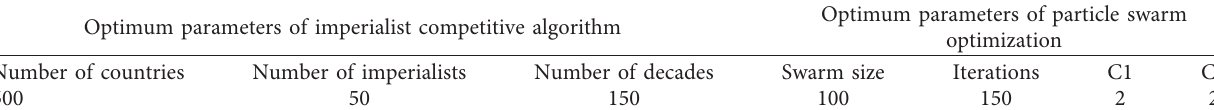
Table 6: Optimum ICA and PSO parameters used in training artificial neural network models.